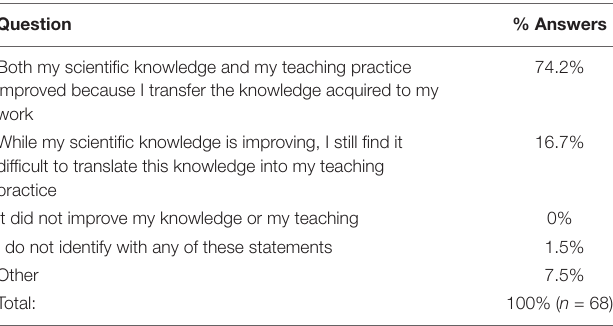
TABLE 5 | Impact of the seminar on improvement in teaching practice. Question % Answers